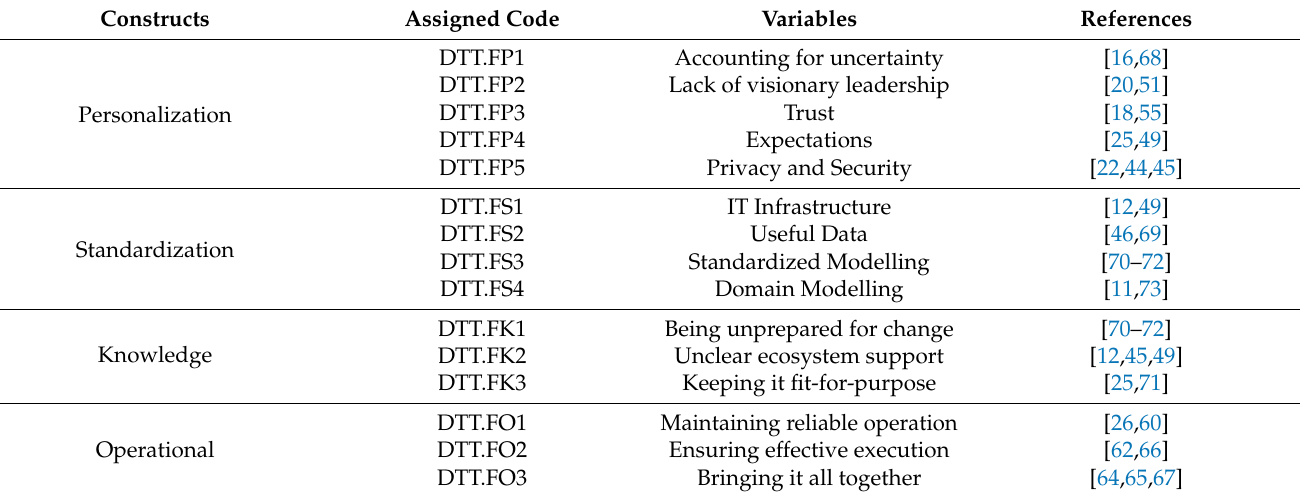
Table 2. Constructs and